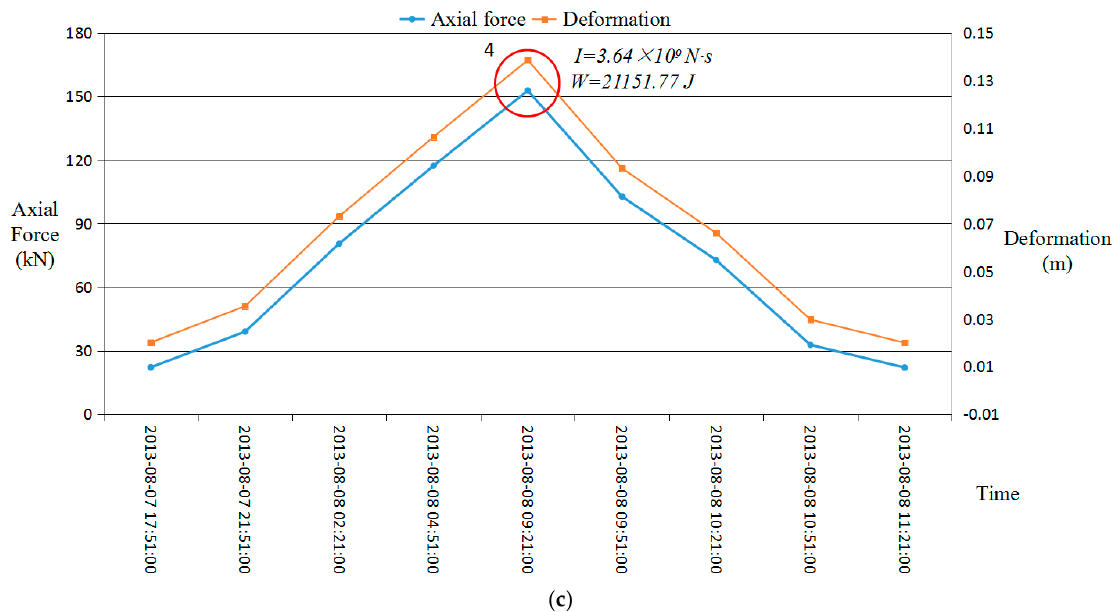
Figure 12. Simplified monitoring data of the time-dependent axial force measured by FRP (the x -axis is time in year-month-day: hour: minute: second). ( a ) Simplified monitoring data; ( b ) the data of the left circle in ( a ); ( c ) the data of the right circle in ( a